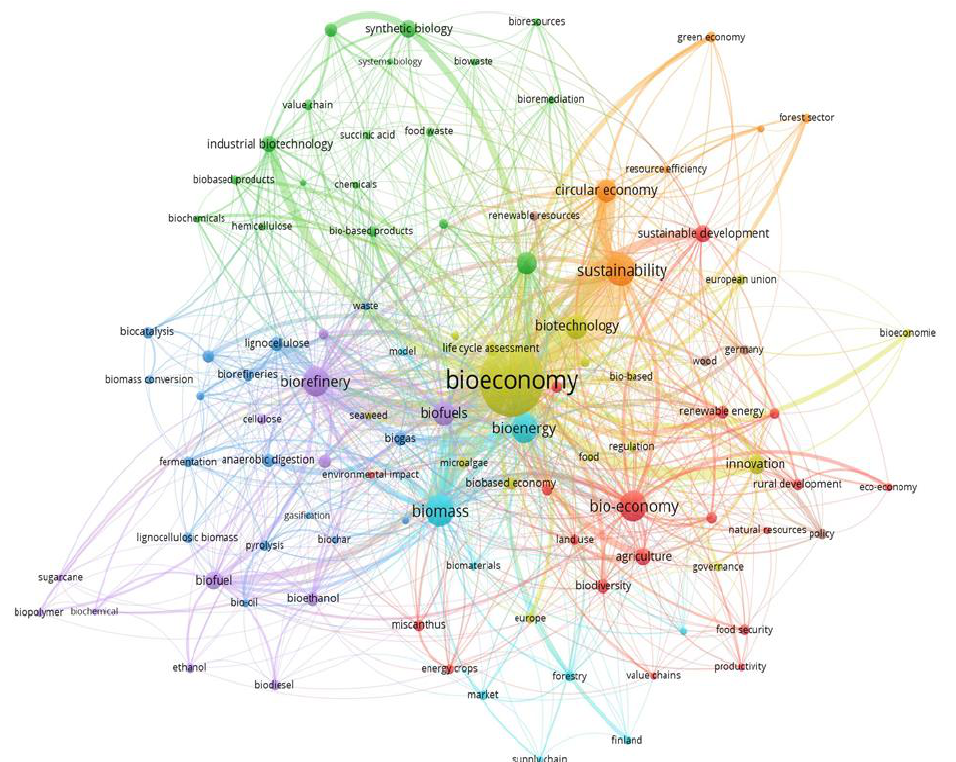
Fig. 1. Top 100 keywords from SCOPUS scientific publications related with